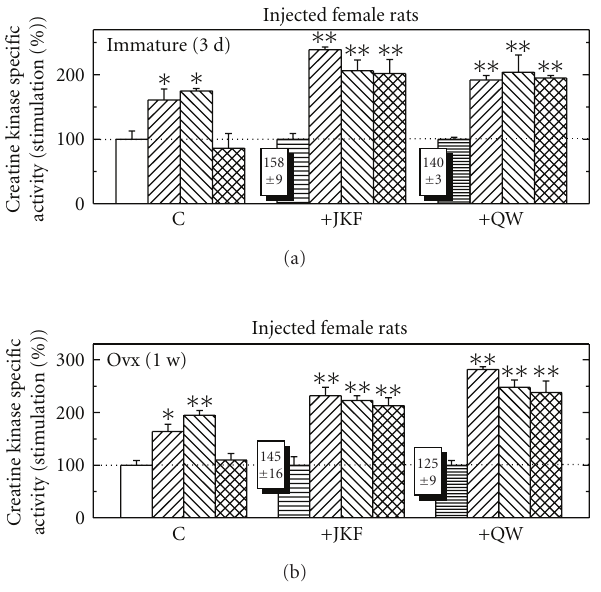
Figure 10: The e ff ect of pretreatment with JKF and QW at 0.2ng/g/rat/day for 3 days in immature female rats (a) or 1 week in Ovx female rats (lower panel) on CK activity compared to the stimulation by E 2 at 5 μ g/rat or Ral at 500 μ g/rat or both, and to the combination of the vitamin D analogs with E 2 , Ral, or both. Treatments were as described in Section 2. Results are expressed as the ratios between the specific activities of CK in hormone- treated and vehicle-injected control animals. The basal activity of CK in was 0 . 78 + 0 . 10 μ mol/min/mg protein for Ovx and 1 . 02 + 0 . 12 μ mol/min/mg protein for immature female rats, n = 5. ∗ P < . 05, ∗∗ P < . 01, in the di ff erence compared to